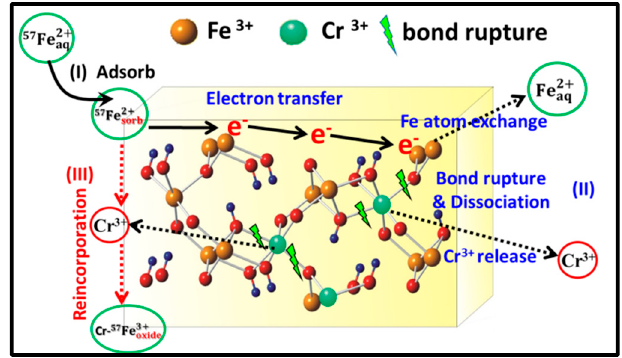
Figure 10. Schematic diagram of the behavior of Cr during the recrystallization of Cr-goethite induced by Fe(II) aq .